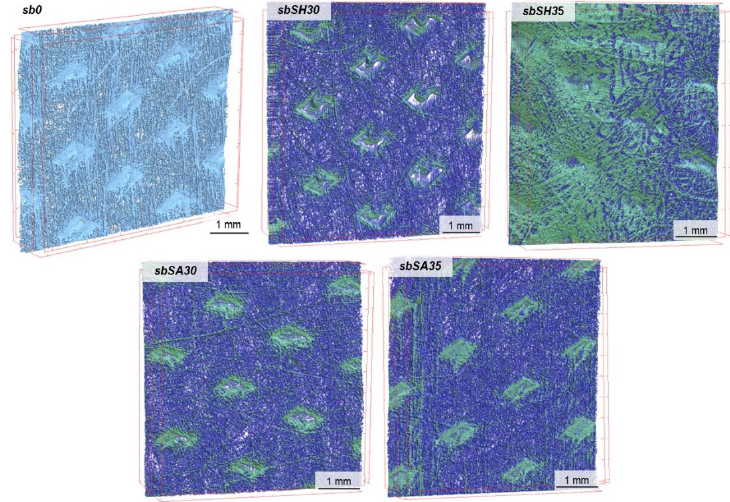
Figure 7. Micro ‐ CT images of unmodified and modified spun ‐ bonded PLA nonwoven fabrics. Figure 7. Micro-CT images of unmodified and modified spun-bonded PLA nonwoven fabrics. Materials 2022 , 15 , 7097